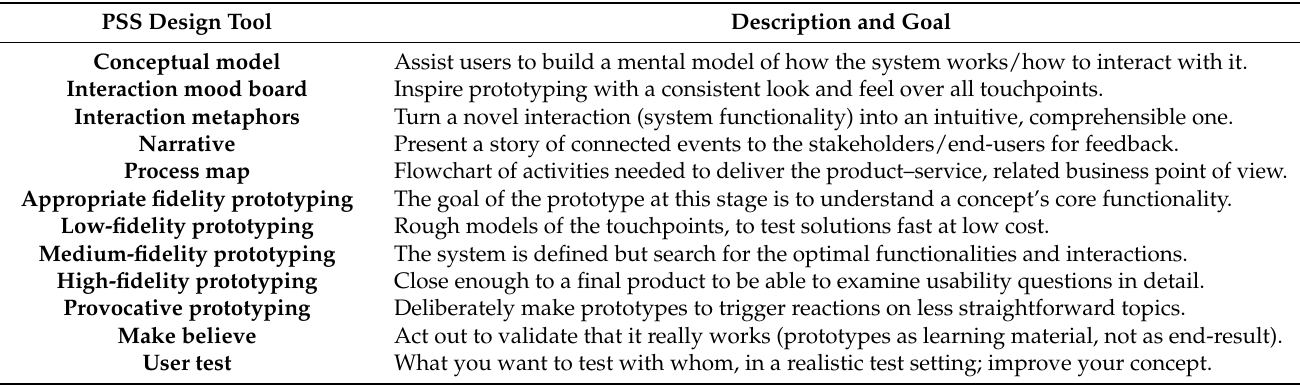
Table 6. PSS design tools and descriptions during the define